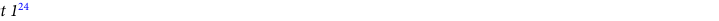
b. Supplemental Table S2 and S3: identified phosphopeptides and proteins